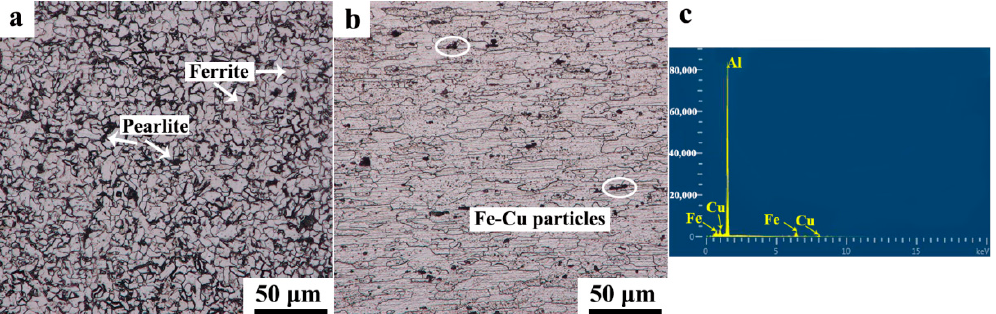
Figure 2. The microstructures in the BM of ( a ) Q235 and ( b ) AA7075 and ( c ) the EDS analysis of Fe-Cu particles in the matrix of AA7075.